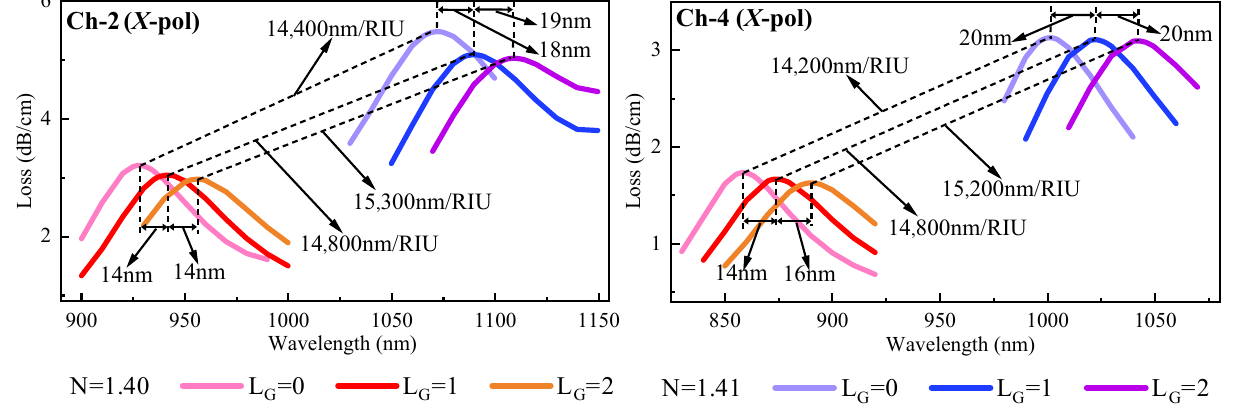
Figure 6. Variation of loss curves for introducing 0 to 2 layers of graphene on the metal surface of Ch-2 and Ch-4.